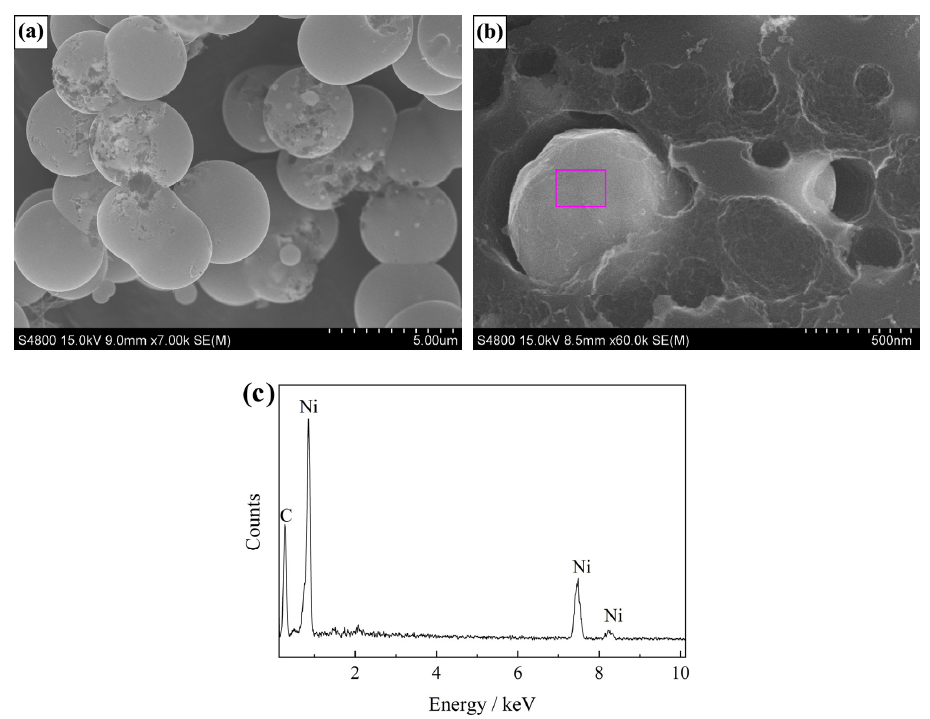
Figure 2. Scanning electron microscopy (SEM) characterization results of the Ni / C aerogel microspheres obtained after the carbonization process in argon: ( a ) low magnification image, ( b ) high magnification image, and ( c ) the corresponding energy dispersive spectrum (EDS).